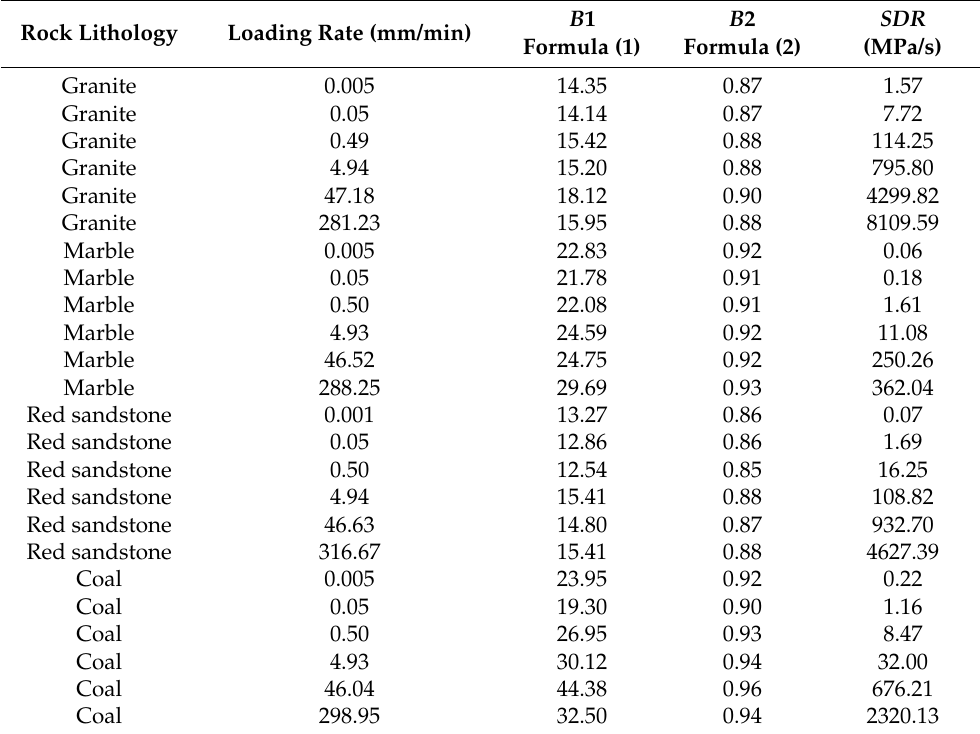
Table 3. Calculation results of B 1, B 2, and SDR under different loading rates in displacement controlled uniaxial compression